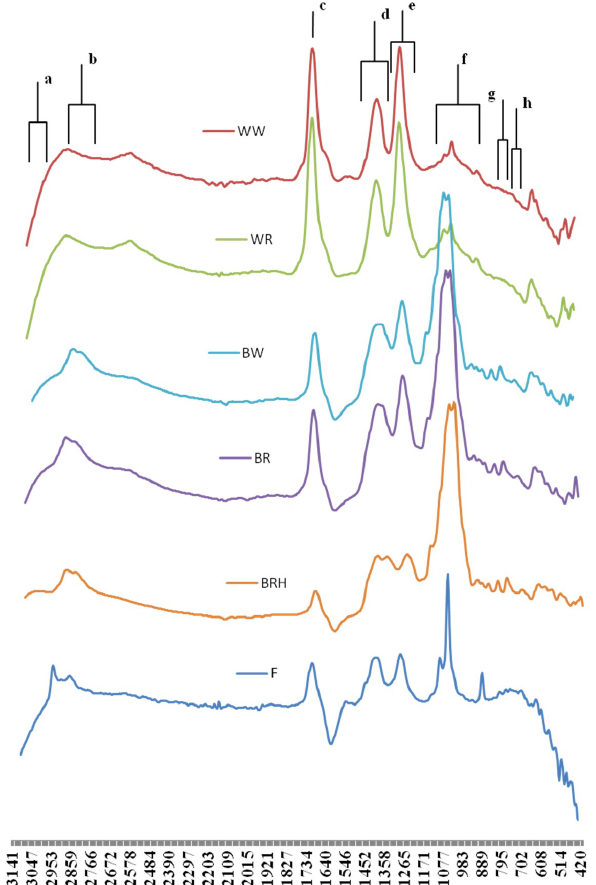
Figure 1. FT-IR absorbance spectra of vinegars. Main absorbance peaks are described using annotations above the upper spectrum: a. 3100–3050 cm − 1 : C–H stretching vibrations of aryl or vinyl groups; b. 2940–2840 cm − 1 : C–H stretching of methyl- and methylene groups of carbohydrates or carboxylic acids; c. 1721 cm − 1 : C=O stretching of carboxylic acids; d. 1425–1380 cm − 1 :